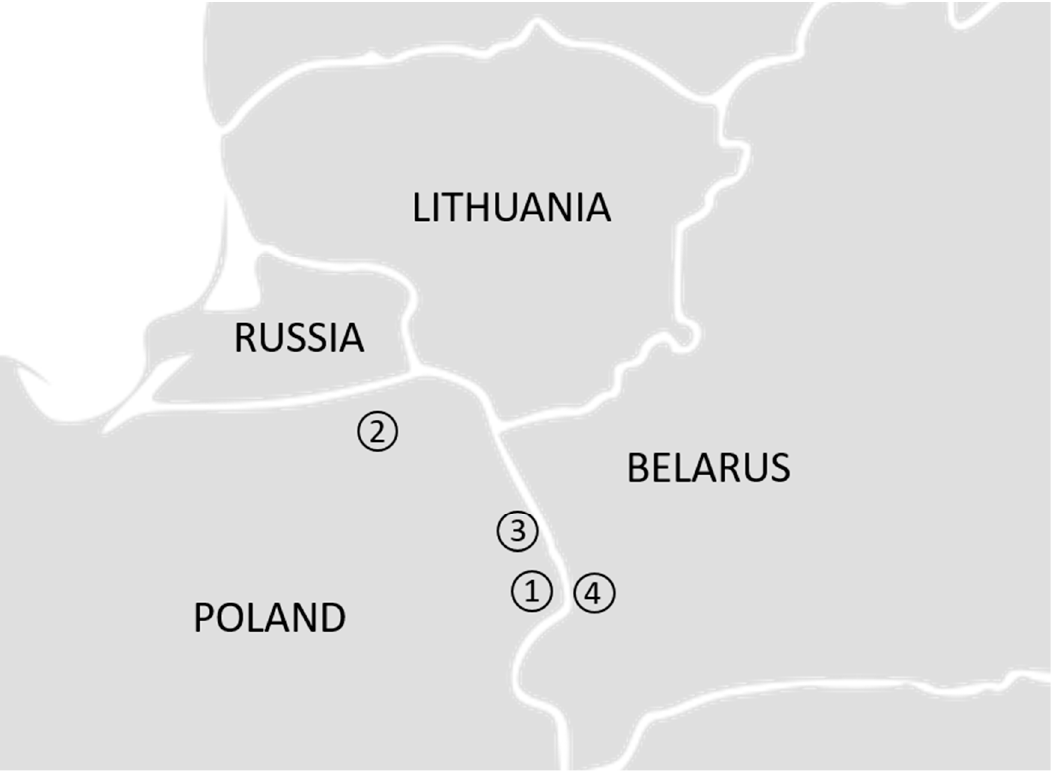
Figure 1. The four free-roaming populations of wisents: (1) Bia ł owieska (Poland), (2) Borecka, (3) Knyszy ń ska, and (4) Belarus.